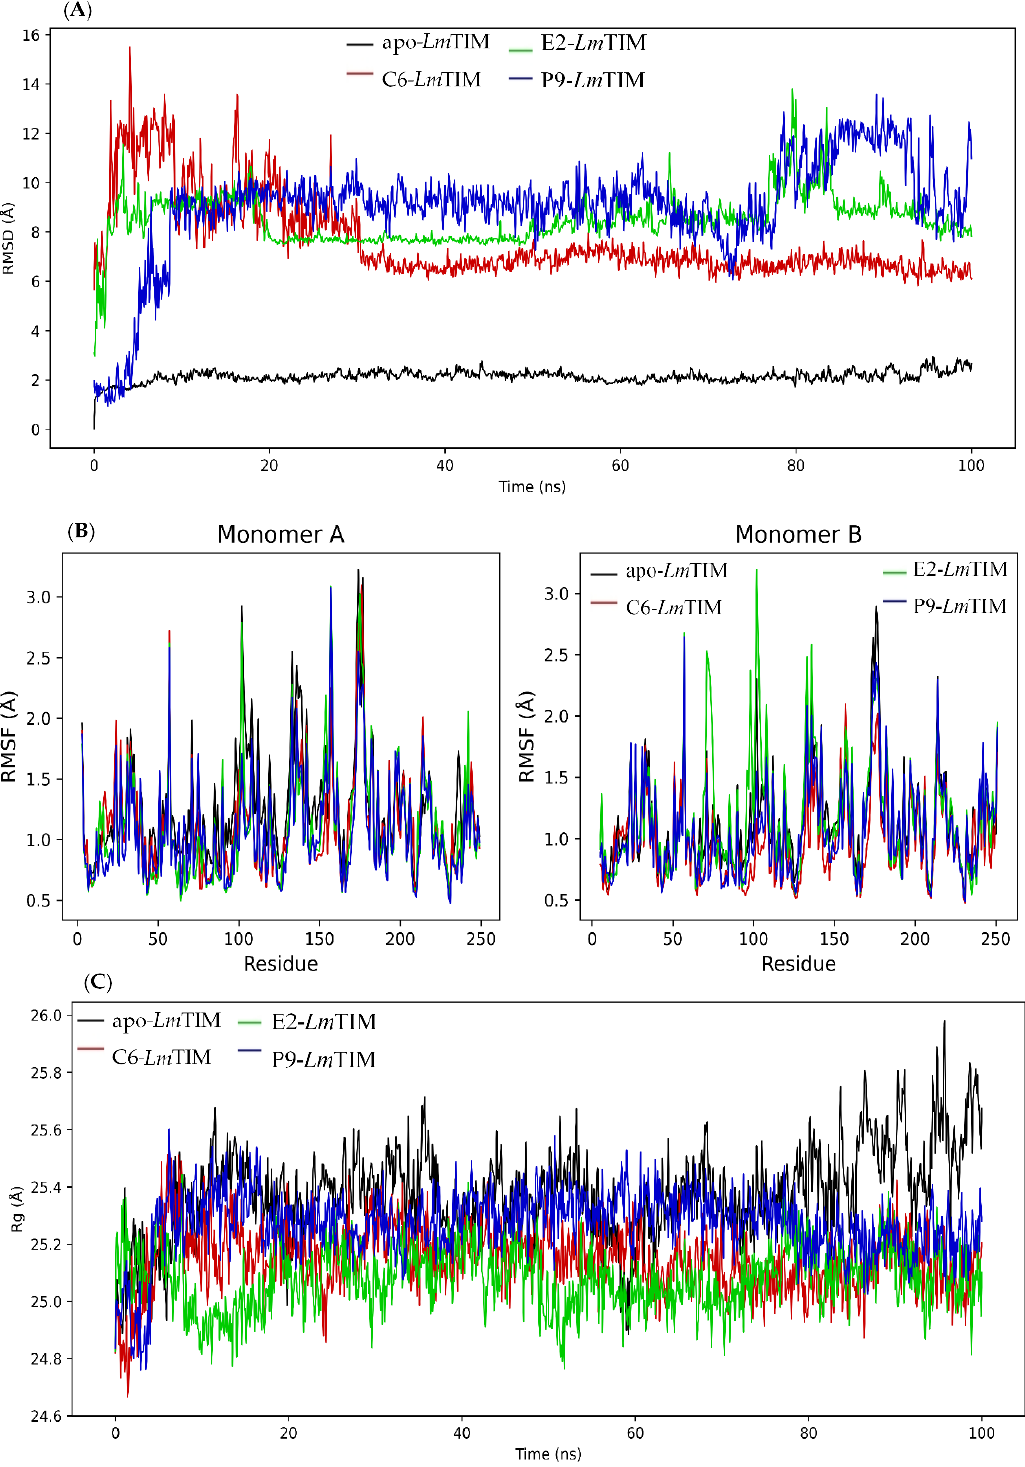
Figure 2. Molecular dynamics simulation of benzimidazole derivatives ( E2 and P9 ) and control compound C6 in complex with Lm TIM. ( A ) Plot of RMSD of the three complexes and apo- Lm TIM. ( B ) Diagram of the RMSF of the three complexes and apo- Lm TIM. ( C ) Diagram of Rg of the three complexes and apo- Lm TIM.